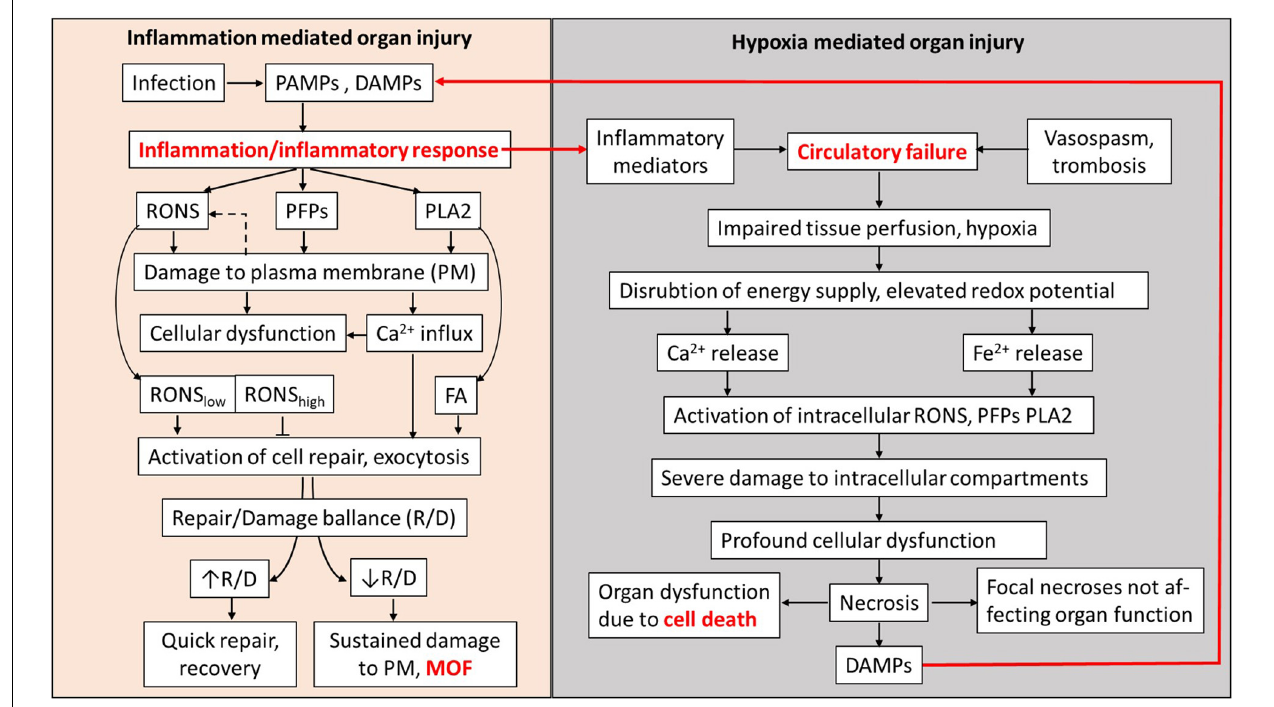
FIGURE 4 | Schematic presentation of MOF pathogenesis mediated by plasma membrane damage. RONS, PFPs, and PLA 2 released in blood and extracellular fluids upon inflammatory response cause damage to plasma membranes (PMs) of well-perfused organs. Influx of Ca 2 + , RONS, and products of PLA 2 simultaneously activate PM repair mechanisms. RONS may also be released from cells (dashed arrow). Damage and the counteracting repair establish a repair/damage balance, which is critical to define whether involved organs will recover or undergo MOF. Hypoxia occurring concomitantly with inflammatory response causes the increase in RONS and Ca 2 + levels and PLA 2 activity inside the affected cells, leading to severe damage of intracellular organelles causing cell death and the release of DAMPs. Inflammatory response and hypoxia interact via the release of inflammatory mediators and DAMPs. In well-perfused organs, the damage to PM and development of MOF have higher impact than hypoxia-mediated damage to intracellular compartments. PAMPs, pathogen-associated membrane patterns; DAMPs, damage-associated molecular patterns; RONS, reactive oxygen and nitrogen species; PFPs, pore forming proteins called also protein forming toxins (PFPs); PLA 2 , phospholipase A 2 ; FA, fatty acids; R/D balance, repair/damage balance; PM, plasma membrane; and MOF, multiple organ failure called also multiple organ dysfunction syndrome